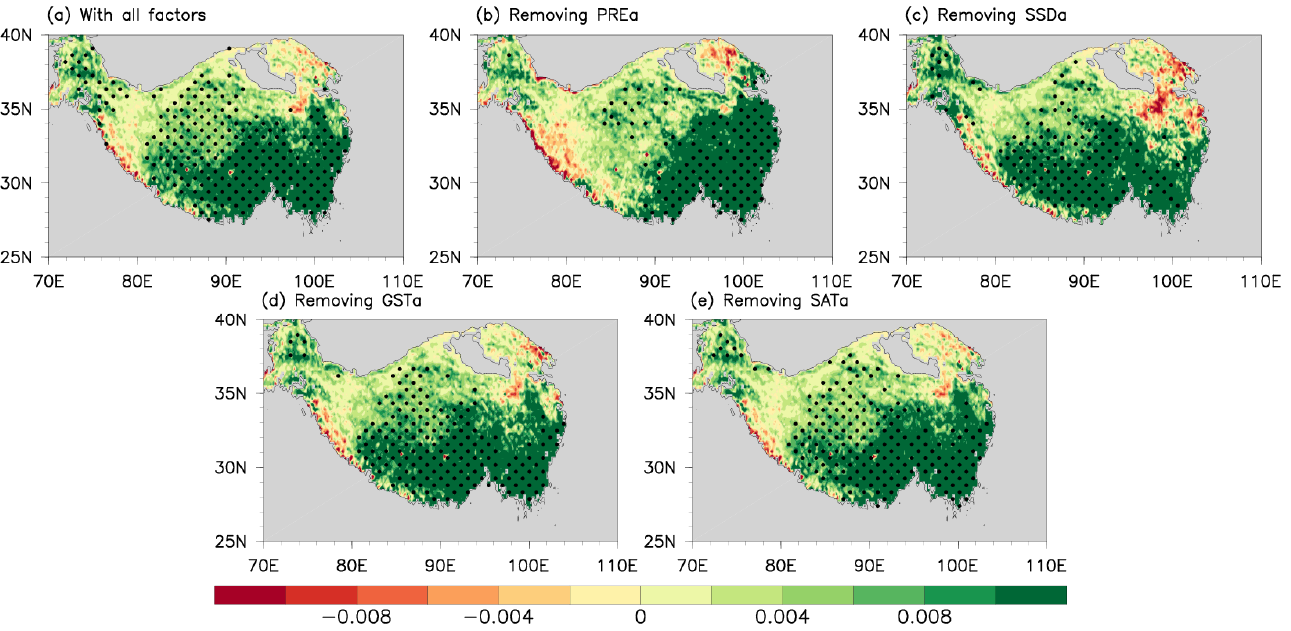
Figure 7. ( a ) JJAS NDVI anomalies regressed upon the combined-effect index for the UNI during the period 1982–2020. The other figures are as in ( a ), but for the regression upon the combined-effect index after removing the effect of the PRE ( b ), SSD ( c ), GST ( d ), and SAT ( e ) anomalies, respectively. NDVI anomalies significant at the 95% confidence level are stippled with black dots. The NDVI anomalies regressed upon the combined-effect index for the DNI show that significantly positive (negative) anomalies appear over the northern (southern)